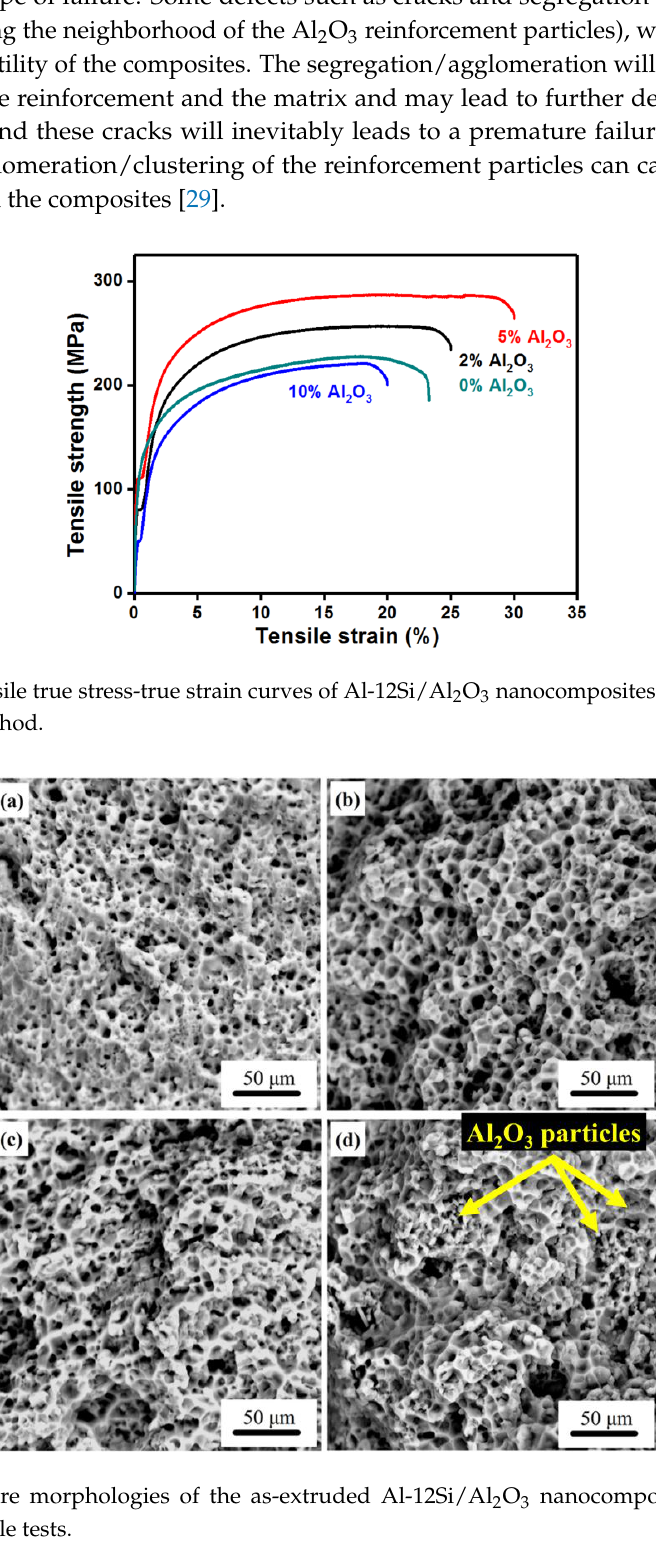
Figure 6. Fracture morphologies of the as-extruded Al-12Si/Al 2 O 3 nanocomposites after room temperature tensile tests. temperature tensile